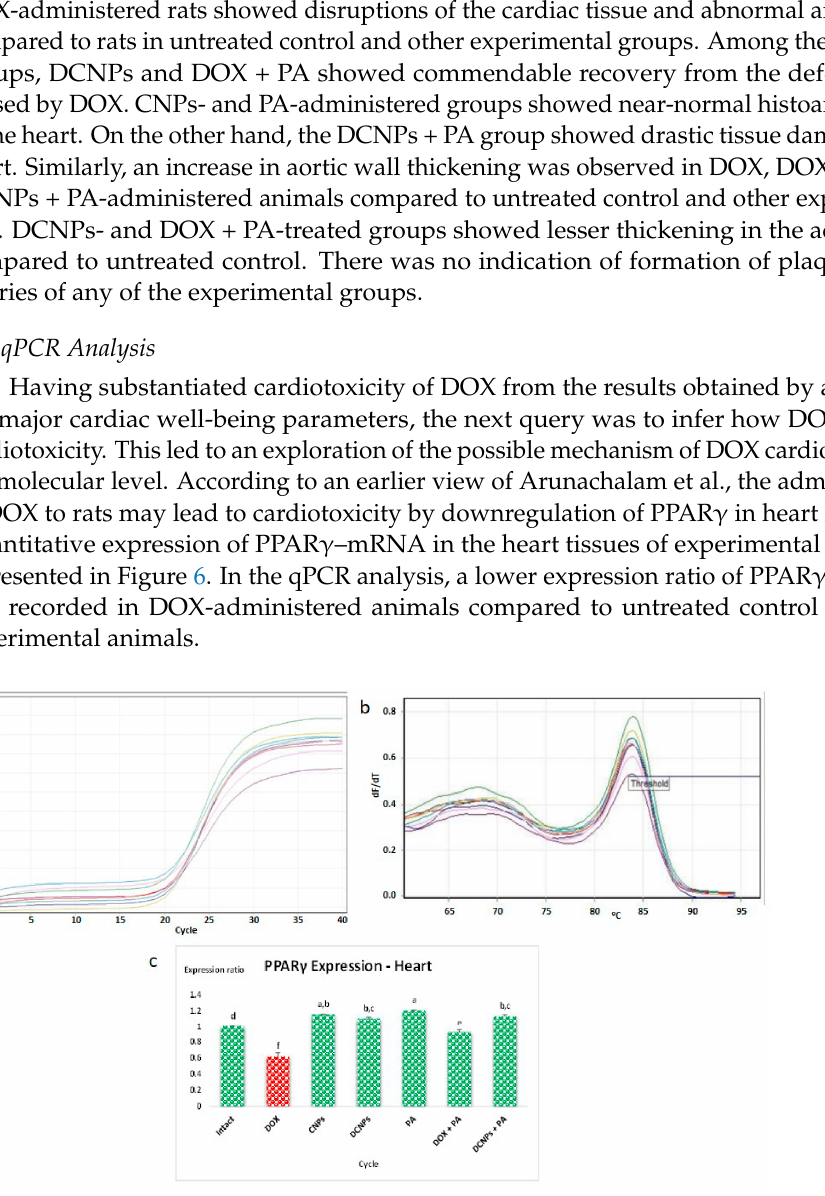
Figure 6. The expression level of PPAR γ in Heart tissues of experimental animals. ( a ). Amplification curve ( b ). Melting curve and ( c ). Expression ratio. Values were expressed as mean ± SD ( n = 3). Bars with different alphabets are significantly different from each other, and bars with same alphabets have insignificant changes ( p <